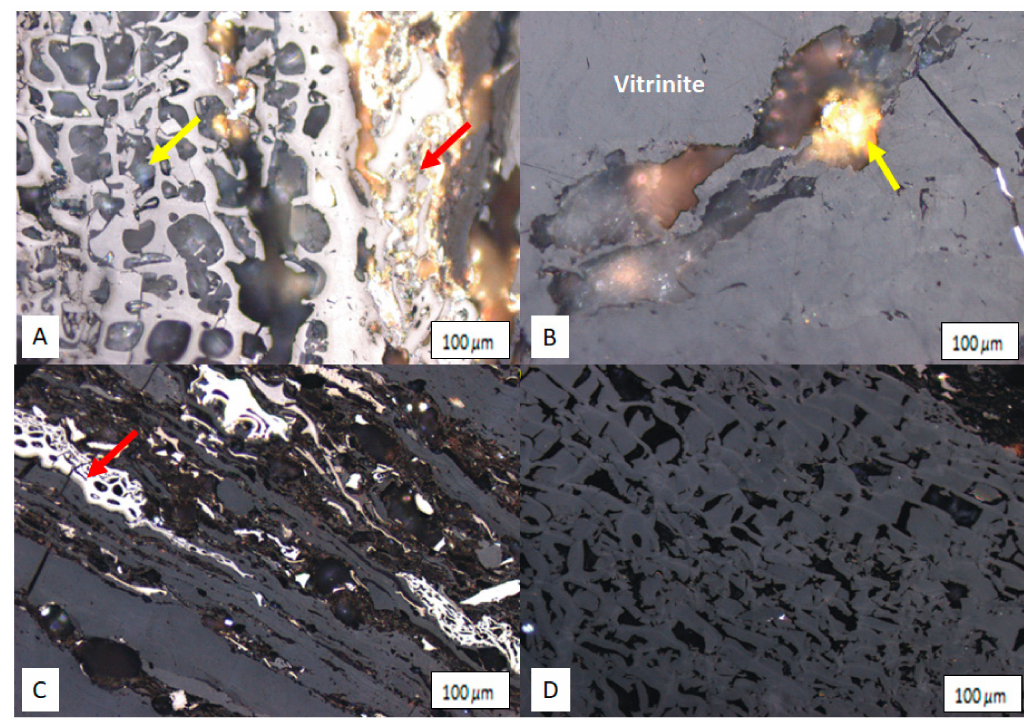
Figure 8. Photomicrograph of coal showing: ( A ) semi-fusinite (yellow arrow) with pyrite (red arrow); ( B ) vitrinite maceral with pyrite minerals; ( C ) fusinite (yellow arrow); and ( D ) semi-fusinite